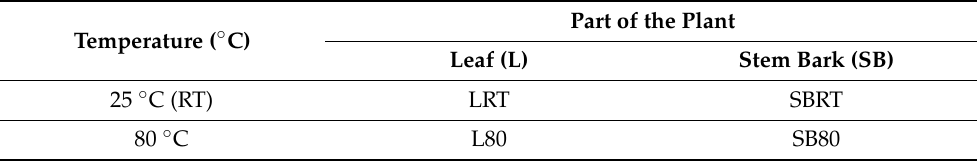
Table 1. The synthesized AgNPs using D. villosa leaves and stem bark at different temperature ranges (25 ◦ C and 80 ◦